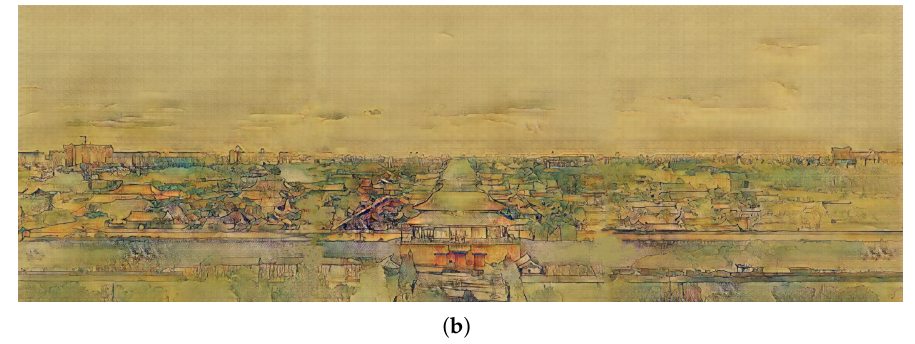
Figure 9. Transforming a real image into a Chinese painting. Our network can handle any size of images. ( a ) Input image; ( b ) Chinese painting produced by our network. The input image has an enormous size of (2300, 768); because of the graphics memory constraints, we divided this huge images into three parts to process.